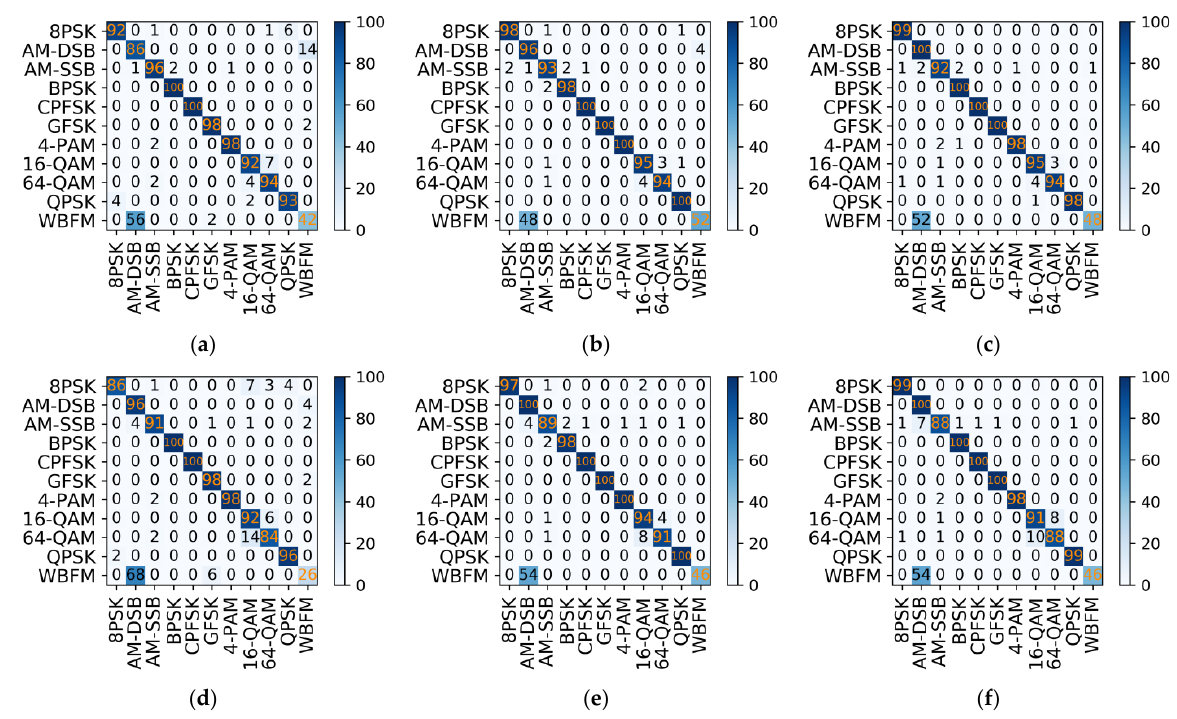
Figure 12. Partial confusion matrices on the RML2016.10a dataset about two networks. ( a ) IQGMCL- 0dB; ( b ) IQGMCL-4dB; ( c ) IQGMCL-12dB; ( d ) MCLDNN-0dB; ( e ) MCLDNN-4dB; ( f ) MCLDNN- 12dB.